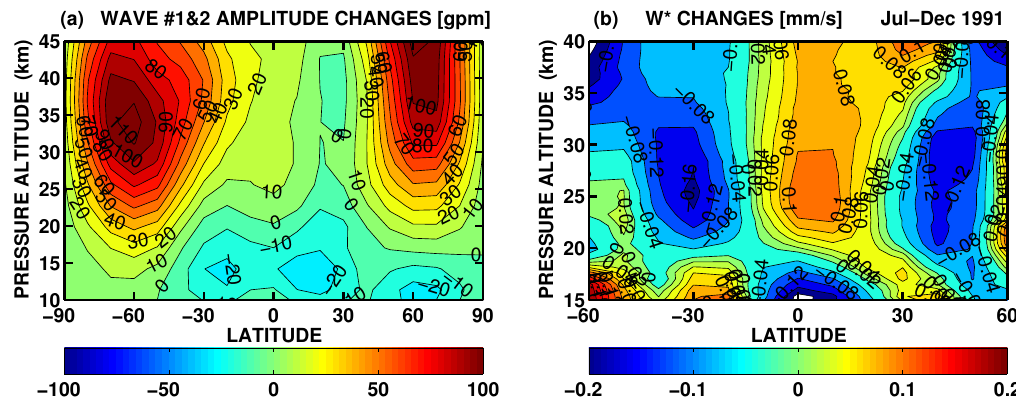
Figure 5. ULAQ-CCM-calculated mean zonal anomalies due to the Pinatubo aerosols (VE-REF): ( a ) amplitude of geopotential wavenumber 1 and 2 (m), during September ´ October ´ November 1991; ( b ) residual mean vertical velocity, averaged from July to December